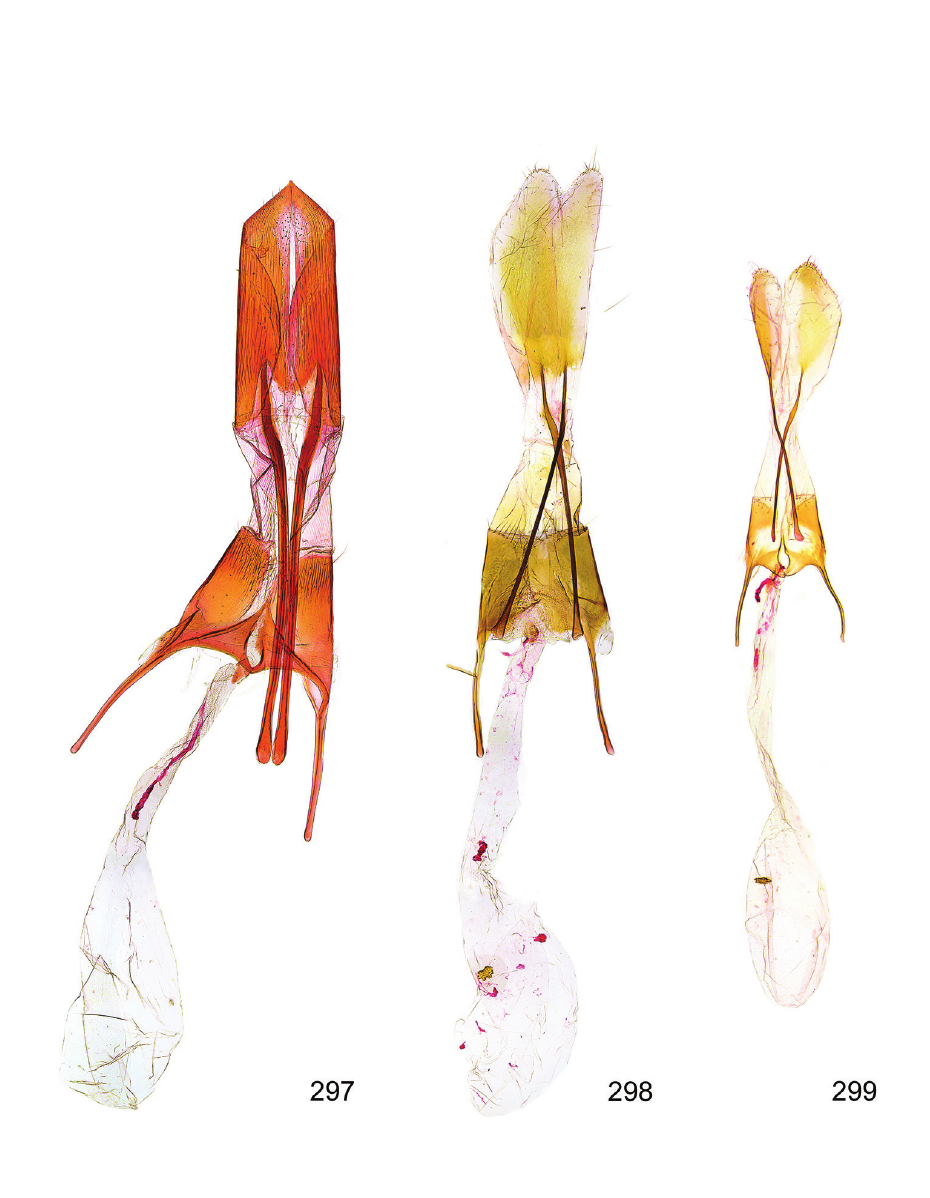
Figures 297–299. Megacraspedus female genitalia. 297 M. argyroneurellus Staudinger, 1871 – Iran, gen. slide Mus. Vind. 16.659 (NHMW) 298 M. squalida Meyrick, 1926 – Spain, GU 16/1428 P.H. (NMPC) 299 M. korabicus sp. n. – Paratype, Macedonia, GEL 1273 P.H.